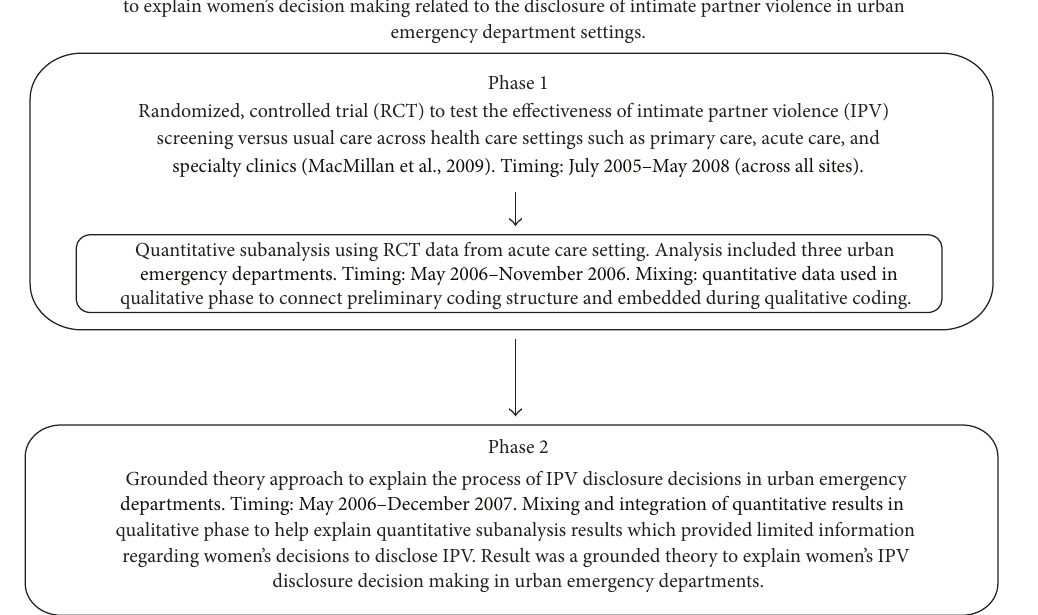
Figure 1: Description of sequential eeplanatory mixed methods study to explain IPV disclosure in emergency